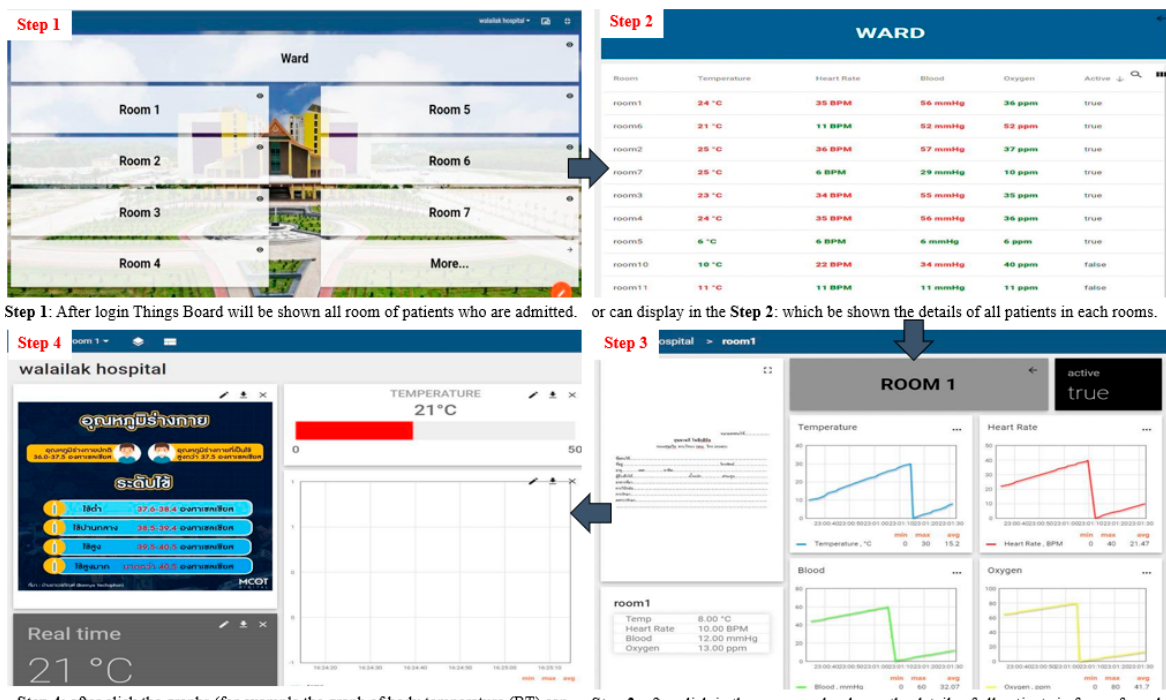
Figure 13. The dashboard screen in the Things Board and steps to display the details of Vital Signals of Patients for nurses and medical professionals monitoring.